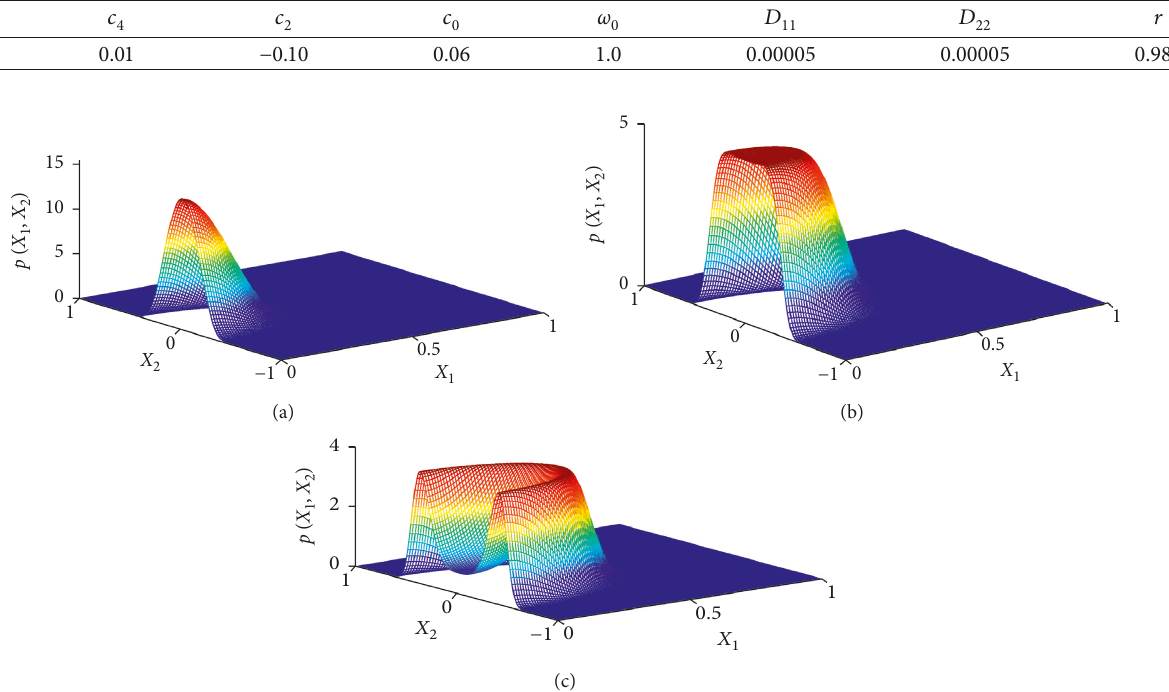
� 0 . 05 for different β 1